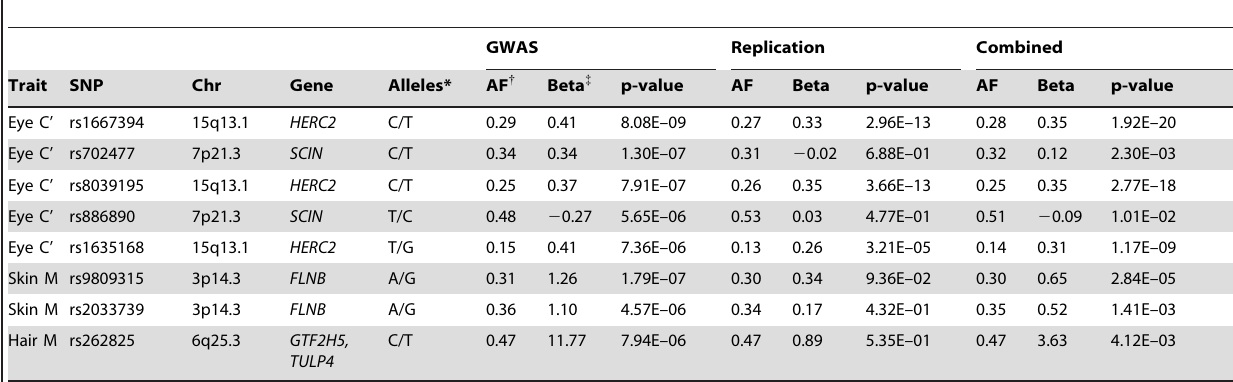
Table 2. GWAS, replication, and combined association results for all signals with p-value , 10 2 5 in the GWAS.